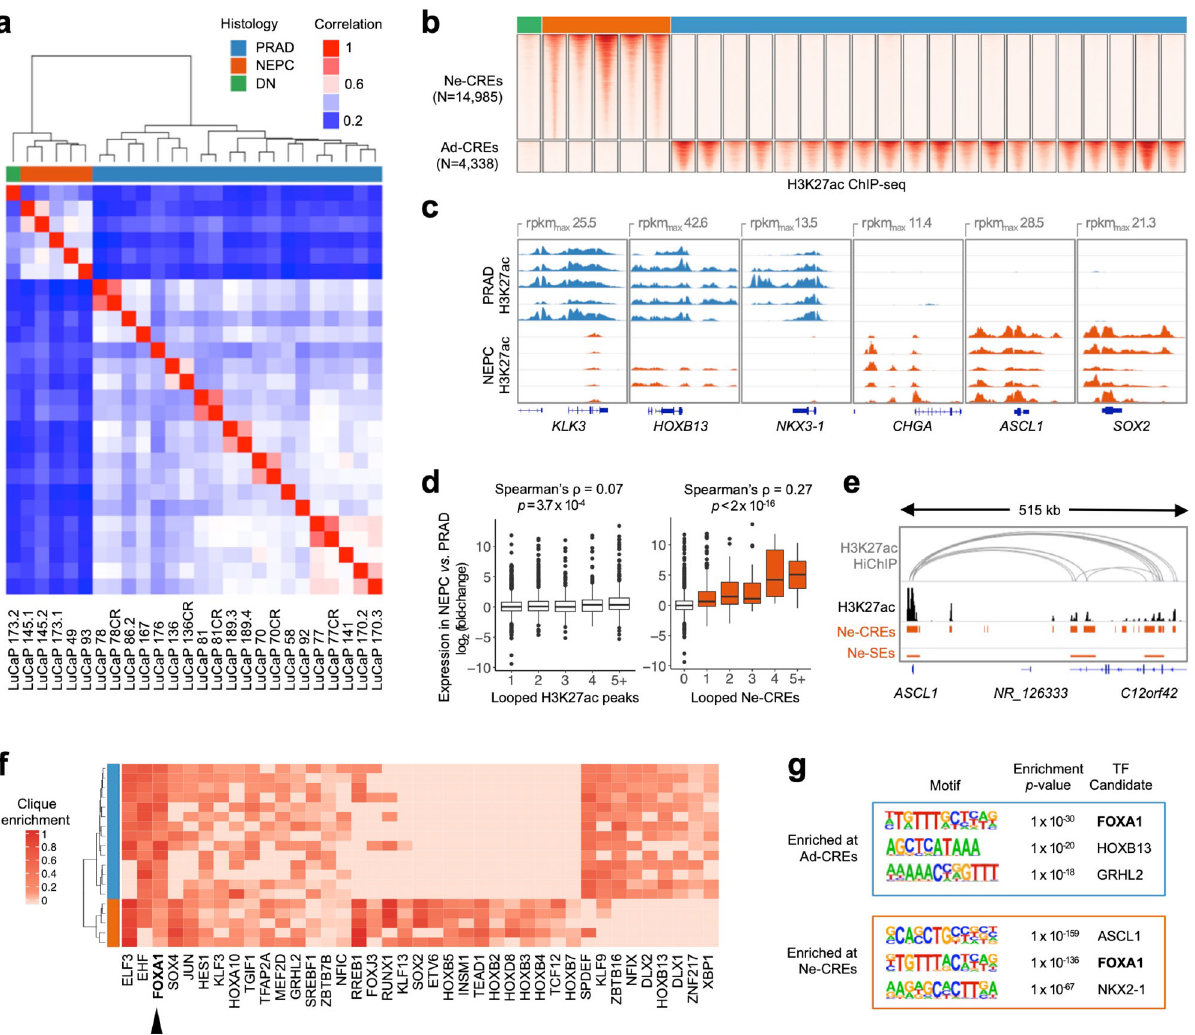
Fig. 1 Epigenomic divergence of PRAD and NEPC. a Hierarchical clustering of PRAD and NEPC based on sample-to-sample correlation of H3K27ac pro fi les. “ DN ” ( “ double-negative ” ) indicates a LuCaP PDX without AR or NE marker expression (see also Supplementary Fig. 1). b Heatmaps of normalized H3K27ac tag densities at differentially H3K27-acetylated regions (±2 kb from peak center) between NEPC and PRAD. “ CREs ” signify candidate regulatory elements. c H3K27ac signal near selected prostate-lineage and NEPC genes. Five representative samples from each histology are shown. d Differential expression (NEPC vs. PRAD) of genes with the indicated number of distinct looped H3K27ac peaks (left) or Ne-CREs (right) detected by H3K27ac